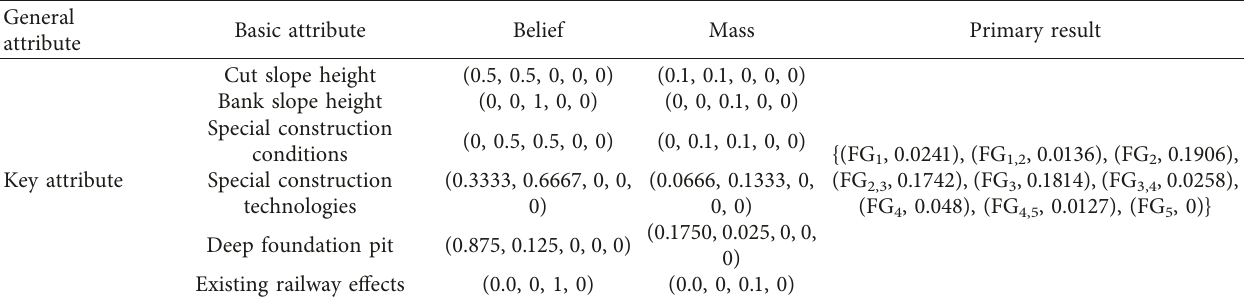
Table 2: Analysis results of risk attributes